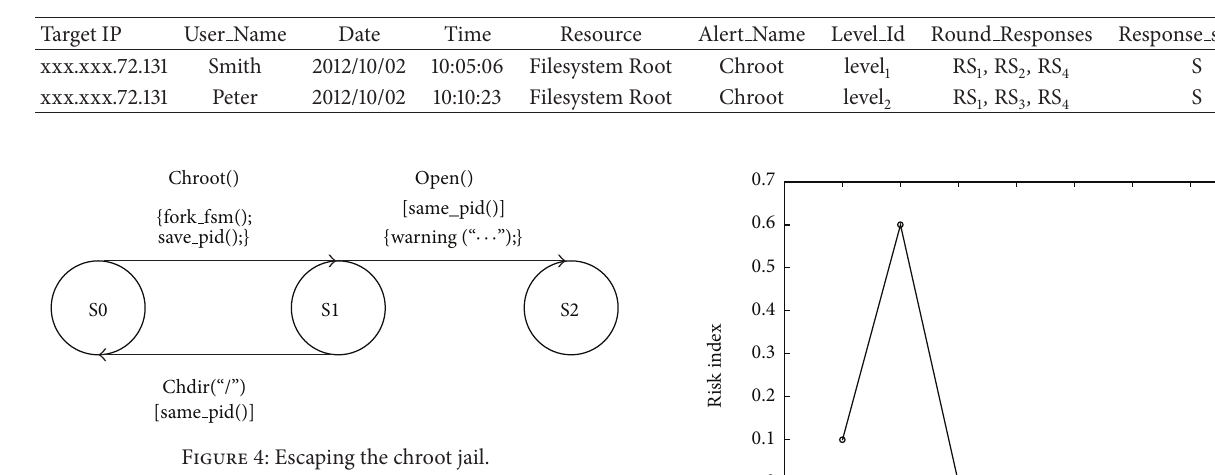
Table 4: Plans history database, after applying the first round of level